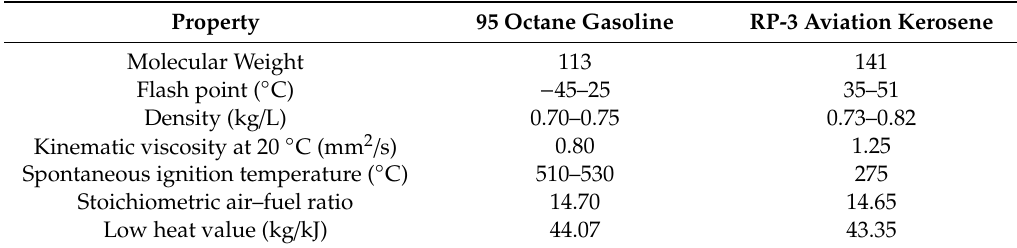
Table 16. Comparison of the properties of two kinds of